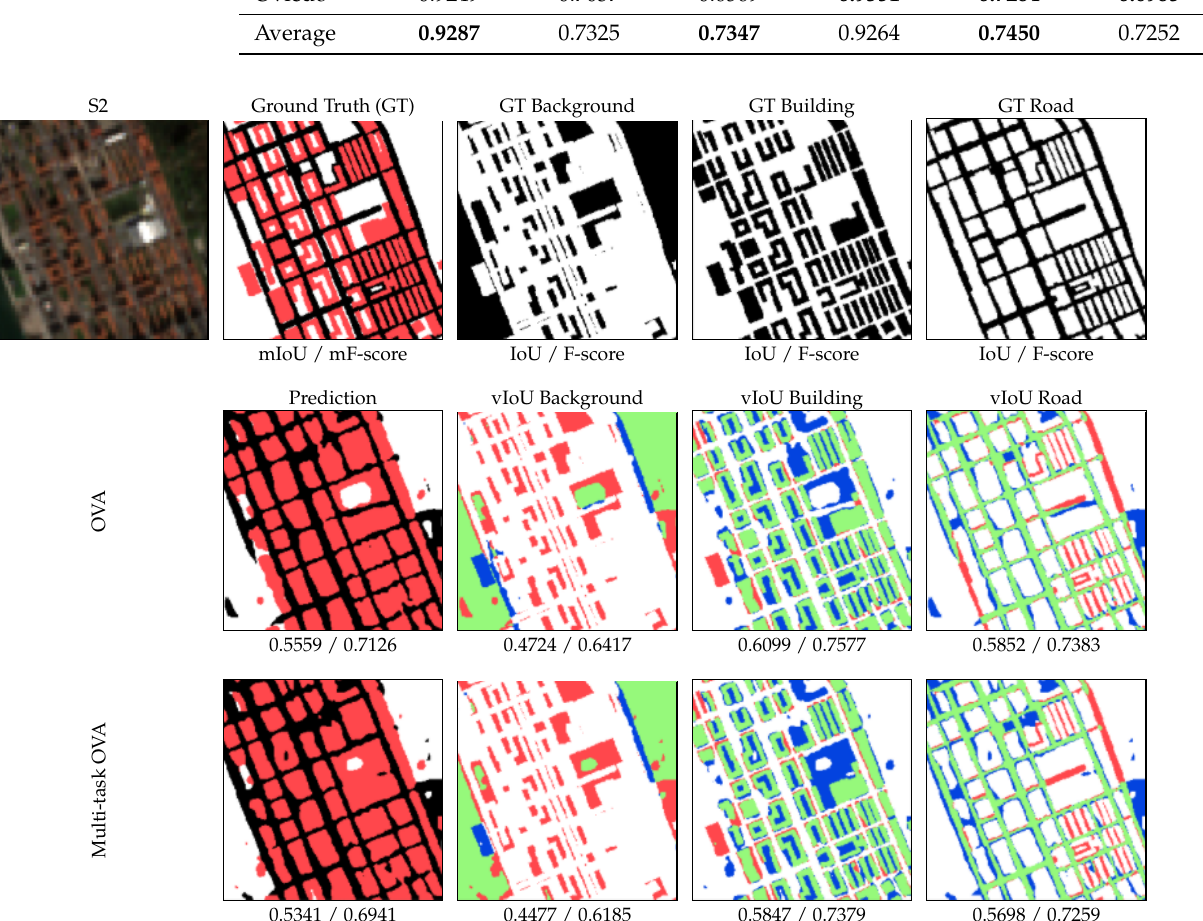
Figure 9. Qualitative results for the benefits of using a multi-task learning scheme. Visual comparison of the results obtained with the OVA binary decomposition strategy and its multi-task variant, for a zone taken from Pamplona city in the test set. TP are presented in green, FP in blue, FN in red and TN in